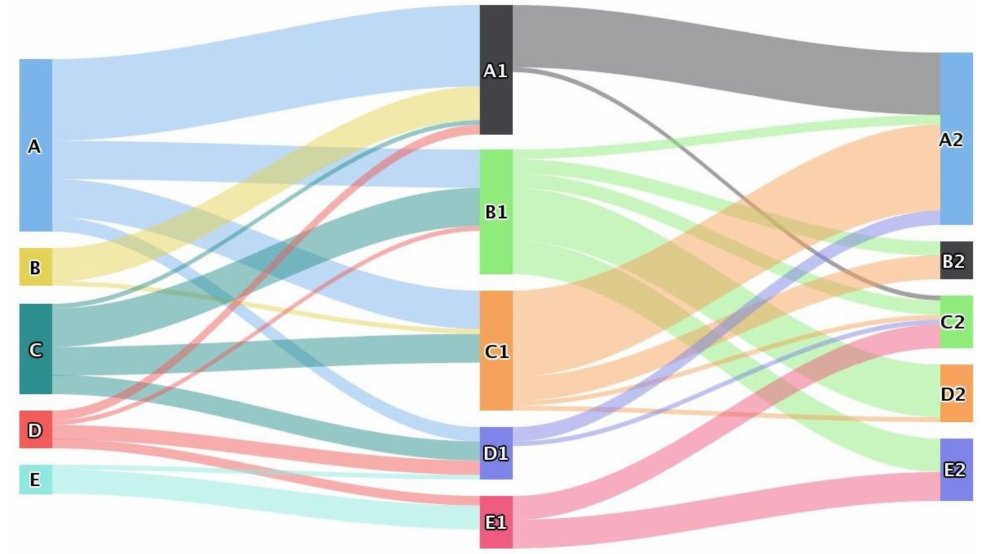
Figure 9. LER transfer situation in typical areas of the Yellow River Basin from 2000 to 2020. Here, A, B, C, D, and E represent low risk area, relatively low risk area, medium risk area, relatively high risk area, and high risk area in 2000, respectively; A1, B1, C1, D1, and E1 represent low risk area, relatively low risk area, medium risk area, relatively high risk area, and high risk area in 2010, respectively; and A2, B2, C2, D2, and E1 represent low risk area, relatively low risk area, medium risk area, relatively high risk area, and high risk area in 2020,